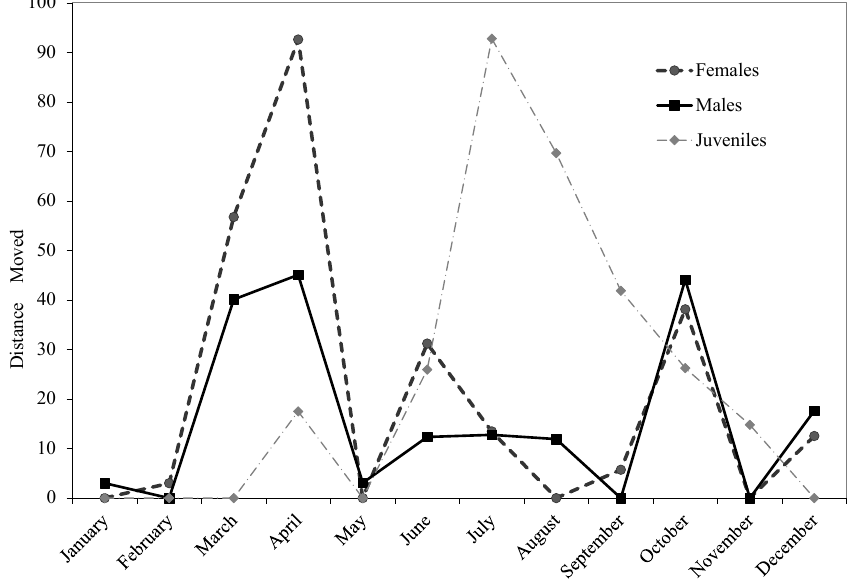
Figure 2. Pooled monthly timing and distances traveled by radiotracked adult male (black), female (dark gray), and juvenile (light gray) A. tigrinum at Brookhaven National Laboratory, Long Island, New York, USA from 2005–2008. Smaller movements that may have been due to radiotransmitter replacement were not included in this figure. The movements of males and females appear to be bimodal, with large movements in the spring following emigration from the breeding pond and shorter movements in the fall. The majority of large juvenile movements coincide with leaving the natal ponds beginning in mid-June and continuing through